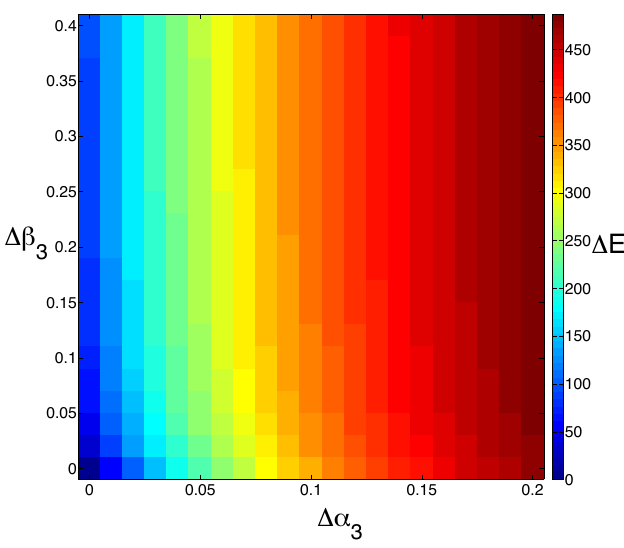
Figure 5. Transition from tumor to tumor-free state by induction of cell death. ( A ) Theoretical dose response curve of stable solutions of E and M as β ( B ) solution curves of E at two different rates of cell death (by chemotherapy) with different initial numbers of cells. Red curves represent the solution of E for β > β ∗ represent the solution of E for β 3